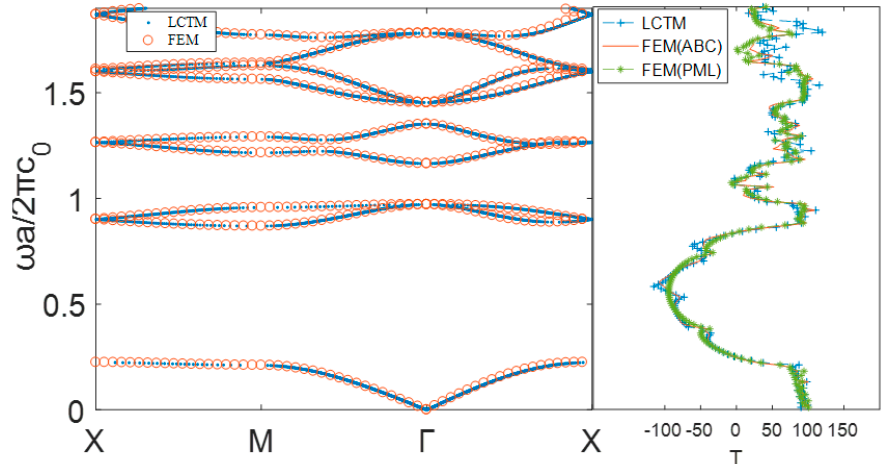
Figure 17. Transmission spectra aurum/epoxy phononic crystal with triangular lattice including circular scatterer, along with the Γ − X direction and the band structures calculated by the proposed LCTM and FEM (ABC), FEM (PML).